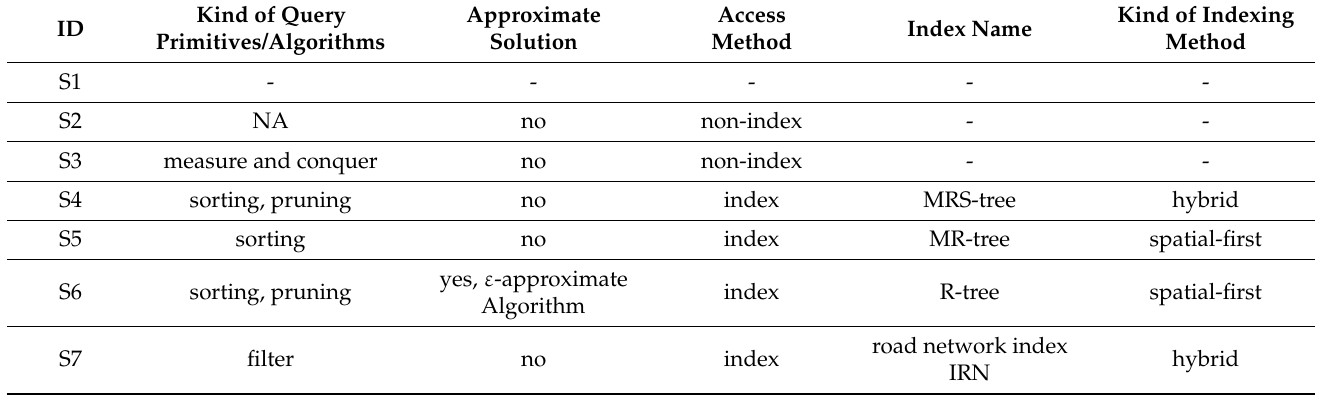
Table 17. Query processing methods applied to the geosocial data in the selected